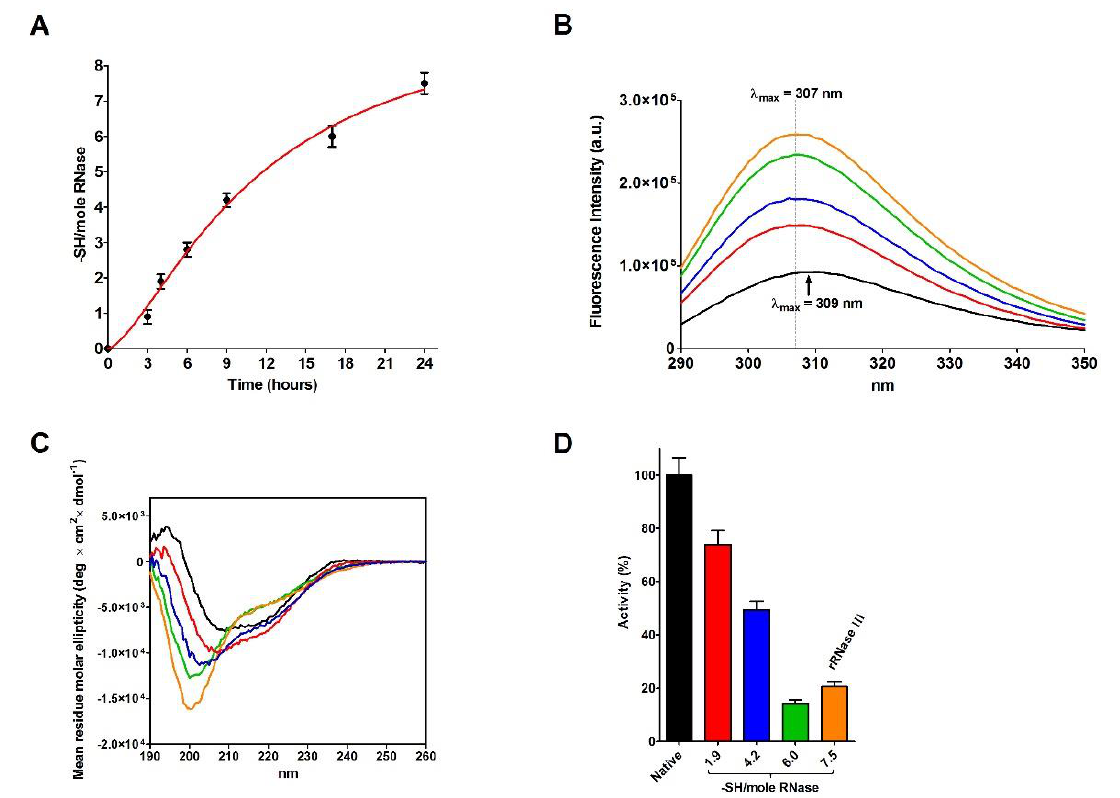
Figure 4. Analyses at different stages of RNase reduction. ( A ) Time-dependent formation of -SH per mole of rRNase III under reducing conditions (see Materials and Methods). The error bars represent the S.D. derived from three independent experiments. ( B ) Intrinsic fluorescence emission spectra of native RNase (black line), rRNase III (orange line), rRNase III with 6.0 -SH/mole (green line), 4.2 -SH/mole (blue line), and 1.9 -SH/mole (red line). All the fluorescence emission spectra were recorded with a protein concentration of 1.25 µ M in 10 mM sodium phosphate buffer pH 7.4, 25 ◦ C. ( C ) CD spectra of native RNase (black line), rRNase III (orange line), rRNase III with 6.0 -SH/mole (green line), 4.2 -SH/mole (blue line), and 1.9 -SH/mole (red line). All the CD spectra were recorded with a protein concentration of 1.25 µ M in 10 mM sodium phosphate buffer pH 7.4, 25 ◦ C. ( D ) Resid- ual activity of rRNase during reduction pathway: native RNase (black column), rRNase III with 1.9 -SH/mole (red column), 4.2 -SH/mole (blue column), 6.0 -SH/mole (green column), and rRNase III (7.5 -SH/mole, orange column). All the experiments were performed as described under Materials and Methods. The error bars represent the S.D. derived from three independent